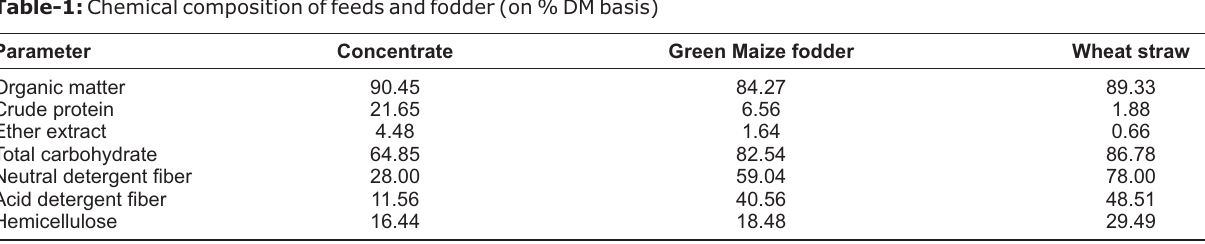
Table-1: Chemical composition of feeds and fodder (on % DM basis) Parameter